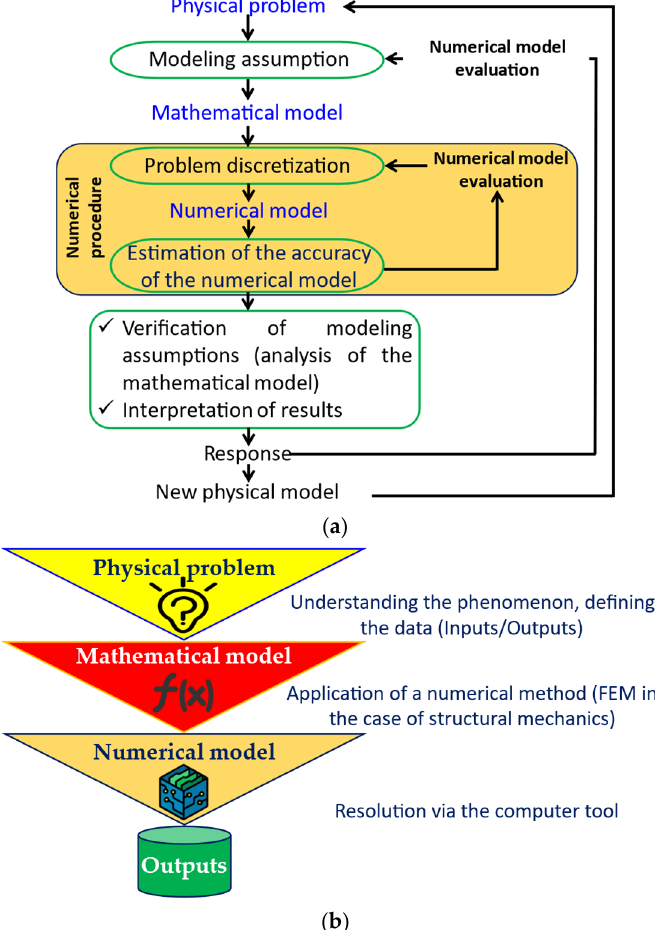
Figure 2. ( a ) Explanatory diagram of the transition from a continuous to a discrete model; and ( b ) approach to solving complicated physical problems. ( b ) approach to solving complicated physical